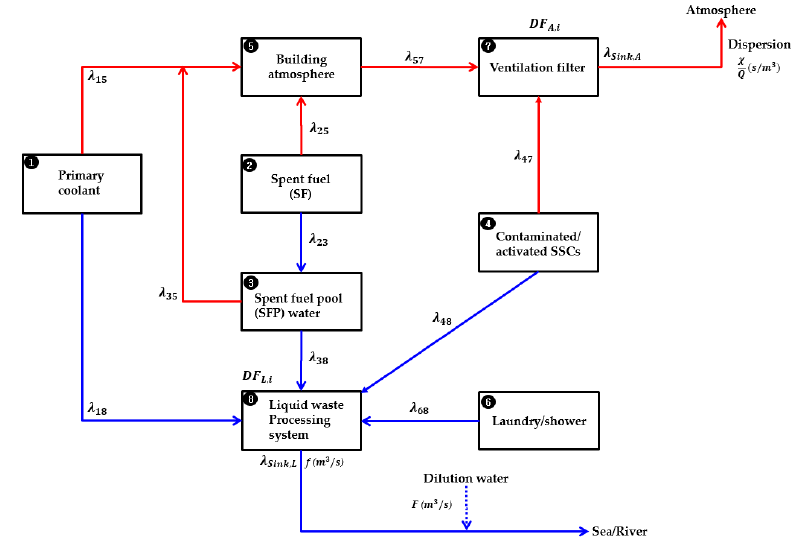
Figure 1. Generalized source term model for radioactive effluent from NPPs after PS. Red- and blue-colored arrows represent release paths of RNs in airborne and liquid effluents, respectively. Symbols and parameters in Figure 1 are provided and explained in Table 3.